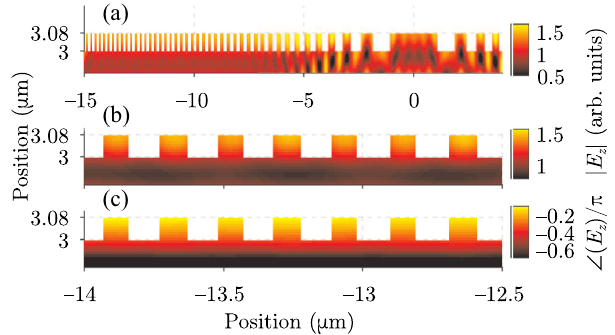
FIG. 6. Two-dimensional finite-difference simulation (in the frequency domain) of an infrared driver propagating to a 0.35-NA zone plate etched in the MgO surface from the MgO substrate (bottom to top). (a),(b) Amplitude of electric field (polarized out of plane) across half of the zone plate (a), and in a smaller region near the edge (b). (c) Phase of infrared field across the same region as in (b). Amplitude and phase modulation varies across the